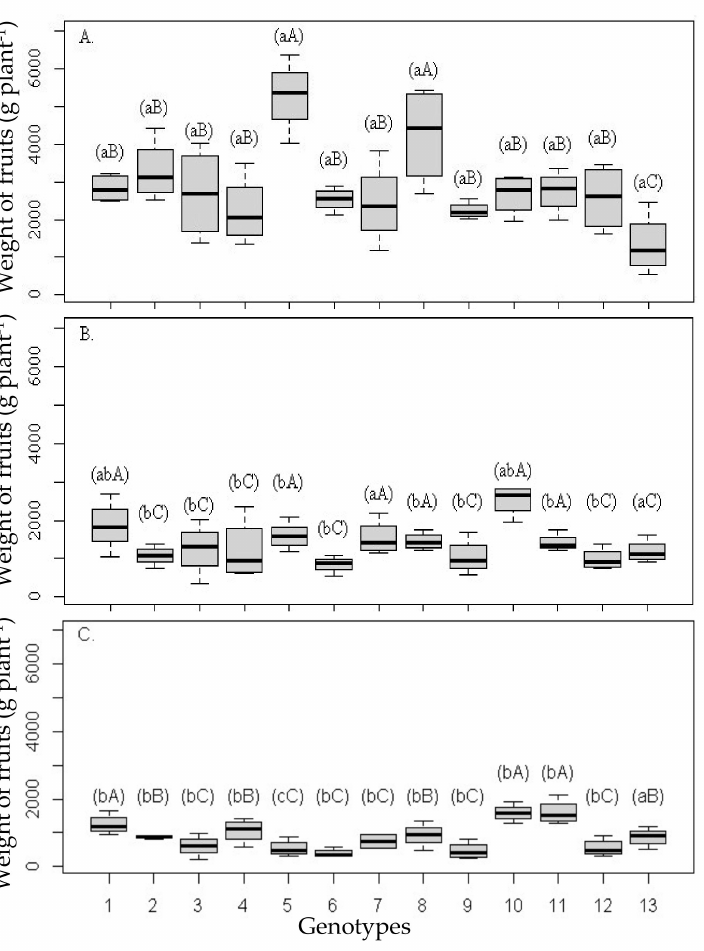
Figure 5. Boxplot relative to the average weight of fruits per plant of 13 citrus rootstocks in combi- nation with ‘Tahiti’ acid lime ( Citrus × latifolia (Yu. Tanaka) Tanaka) under irrigation with waters Table 1. Boxplots with the same lowercase letter do not differ statistically, according to the Tukey test between salinity levels ( p ≤ 0.05), and those with the same uppercase letter belong to the same genotype group, according to the Scott–Knott test ( p ≤